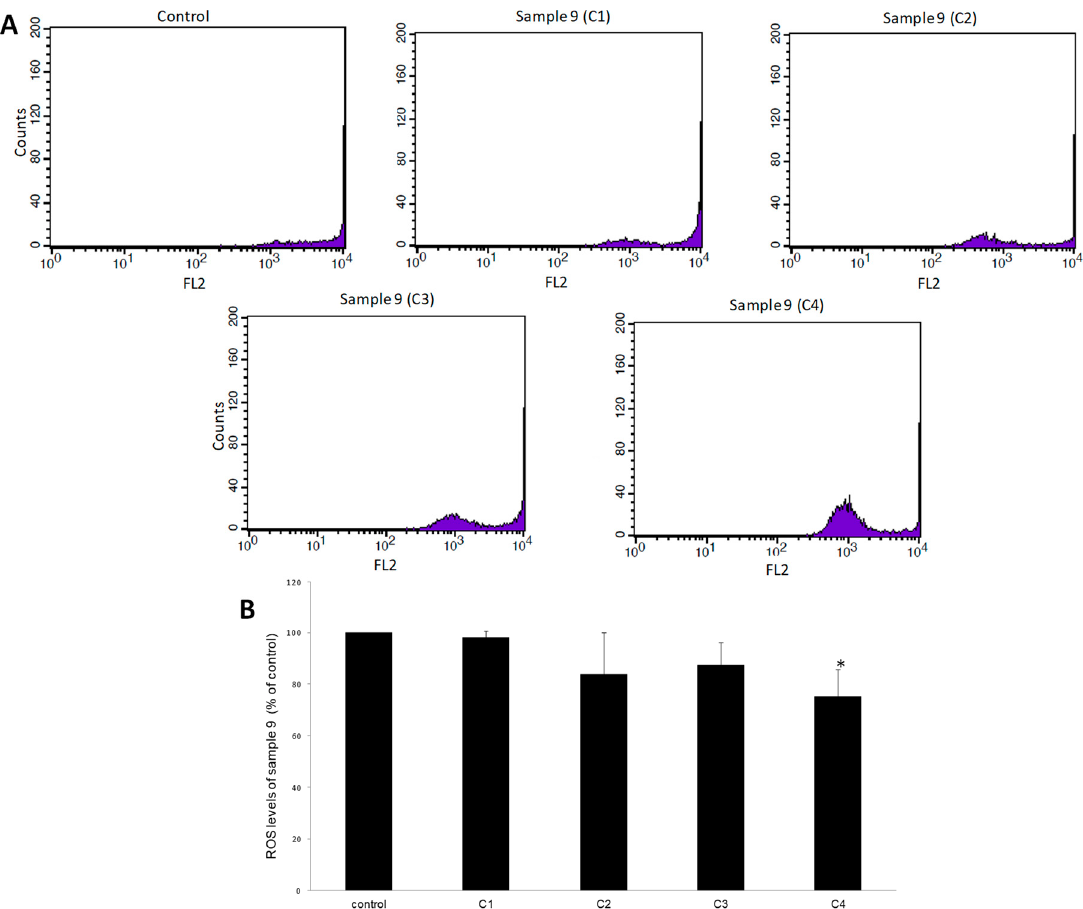
Figure 5. The effects of sample 9 on ROS levels in EA.hy926 cells after treatment for 24 h, as assessed by flow cytometry. ( A ) The histograms of cell counts versus fluorescence of 10,000 cells after treatment with sample 9. ( B ) Bar charts demonstrate the ROS levels as % of control as estimated by the histograms in EA.hy926 cells after treatment. C1, C2, C3, C4: 200, 400, 800, and 1600 μ g/mL, respectively. * Statistically significant compared to the control cells. FL2: The detection of fluorescence using 488 and 580 nm as the excitation and emission wavelength, respectively.